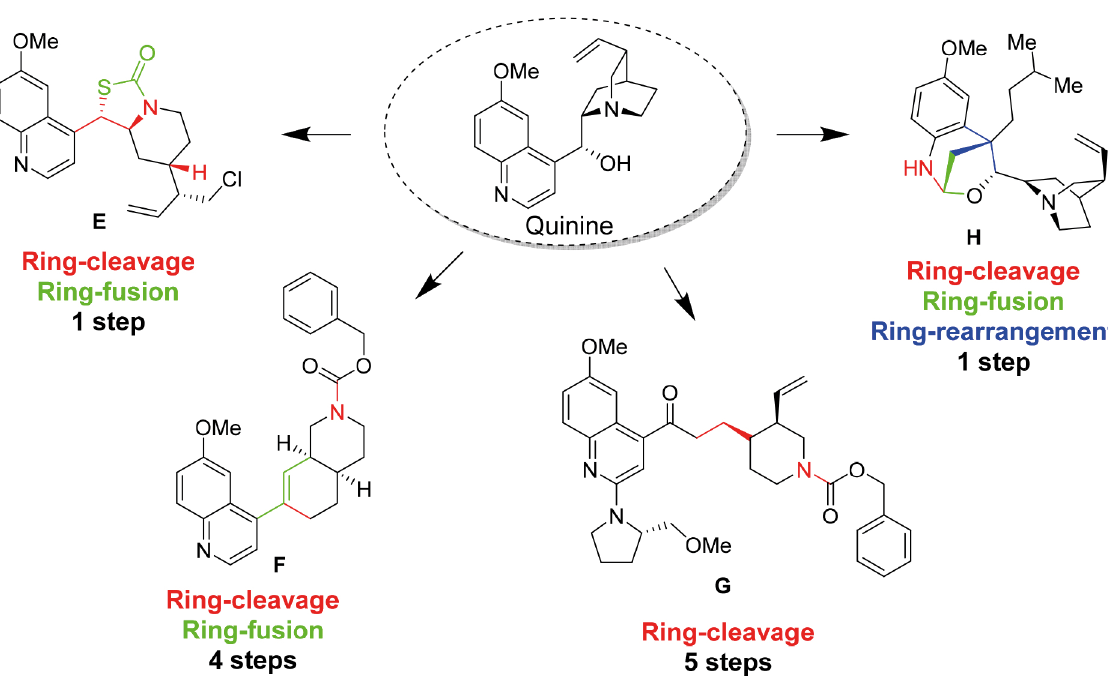
FIGURE 12 - Ring-distortion strategies to access quinine-based